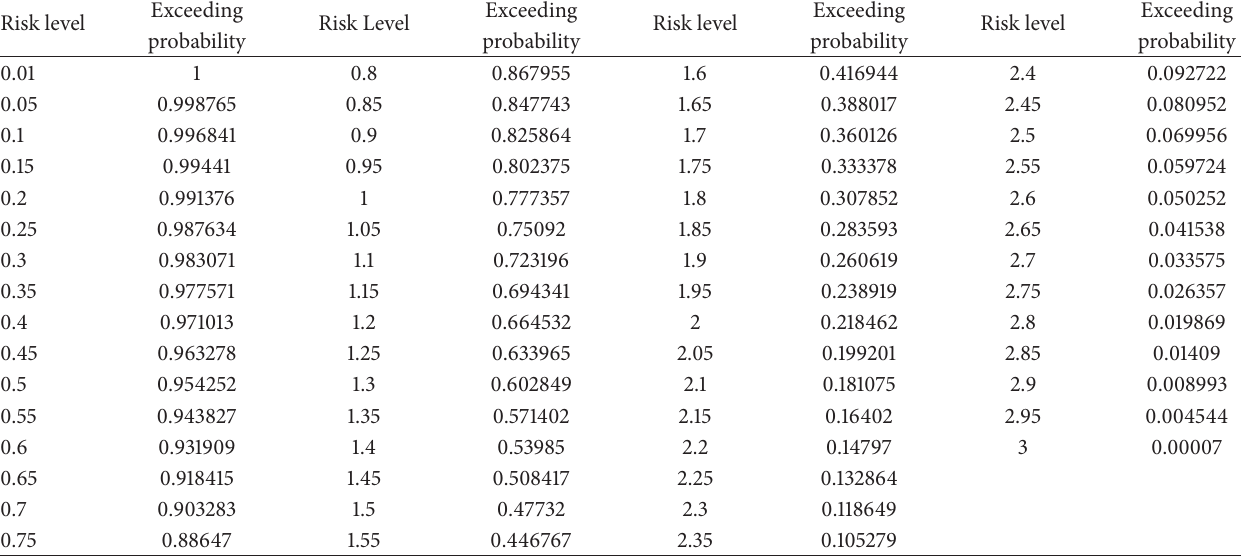
Table 3: The exceeding probability of drought risk in Qilin.